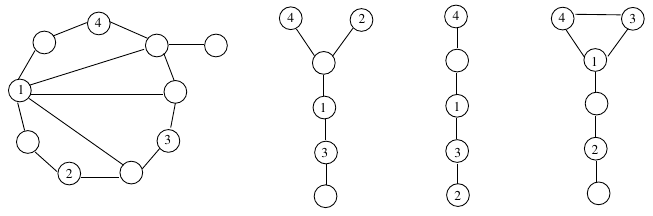
Figure 3: A step in the proof of Proposition 2.1.